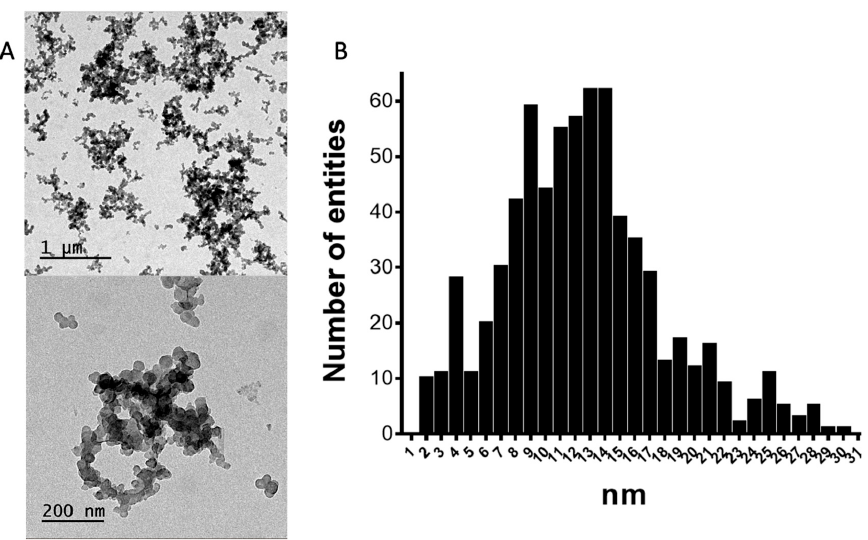
Figure 3. ( A ) The transmission electron microscopy (TEM) images obtained with a JEOL 1400 microscope at an accelerating voltage of 120 kV at two resolution levels. ( B ) The histogram obtained by analyzing 4 images (displayed in Figure S1, Supplementary Materials). n =